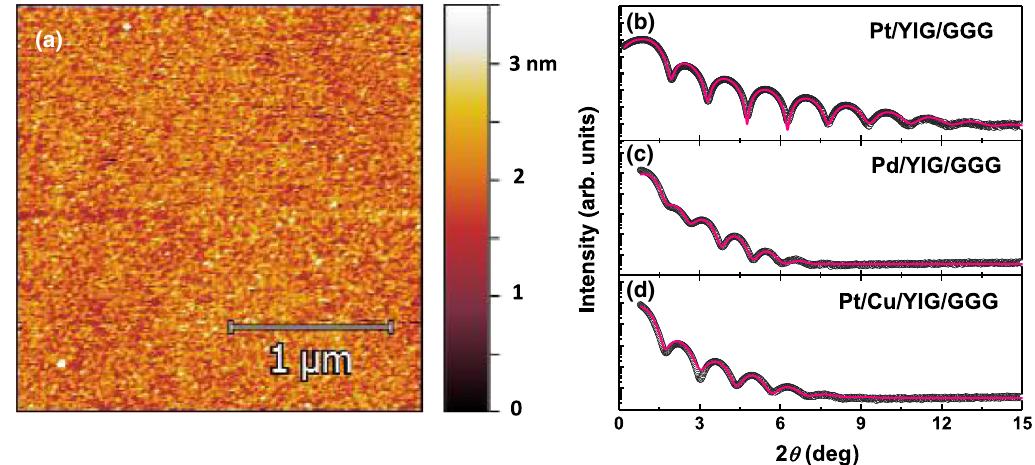
FIG. 6. (a) AFM image of a 50 - μ m-thick LPE YIG film over an area of 2 . 5 × 2 . 5 μ m 2 with a rms roughness of 0.34 nm. XRR curves of (b) Pt/YIG, (c) Pd/YIG, and (d) Pt/Cu/YIG hybrid structures are illustrated. The black open symbols are the experimental data, while the red lines are the fitting